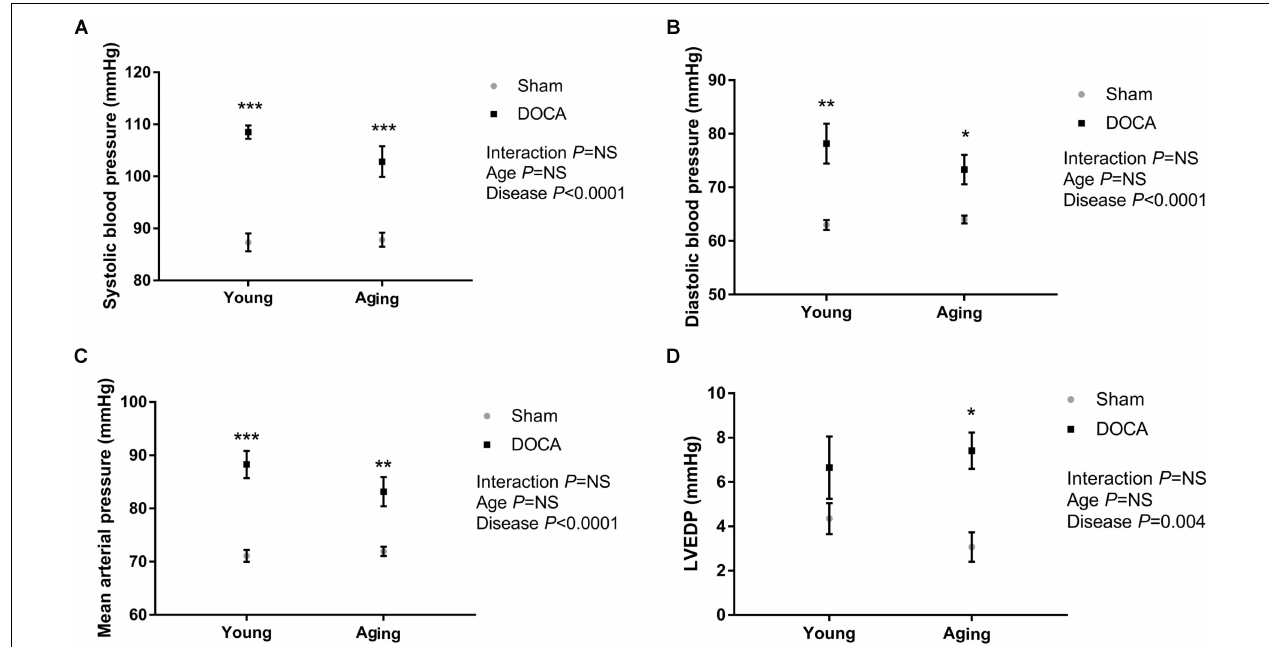
FIGURE 1 | Blood pressure (BP) and left ventricular end-diastolic pressure (LVEDP) of young and aging sham and DOCA mice. (A) Systolic BP and (B) diastolic BP were higher in young and aging DOCA compared to sham mice. (C) Mean arterial pressure was only significantly higher in young DOCA compared to sham mice. (D) LVEDP was only significantly higher in aging DOCA compared to sham mice. Values are mean ± SEM. ∗ q < 0.05, ∗∗ q < 0.01, ∗∗∗ q < 0.001 DOCA vs. sham control. Sample size: aging DOCA n = 8, all other groups n =